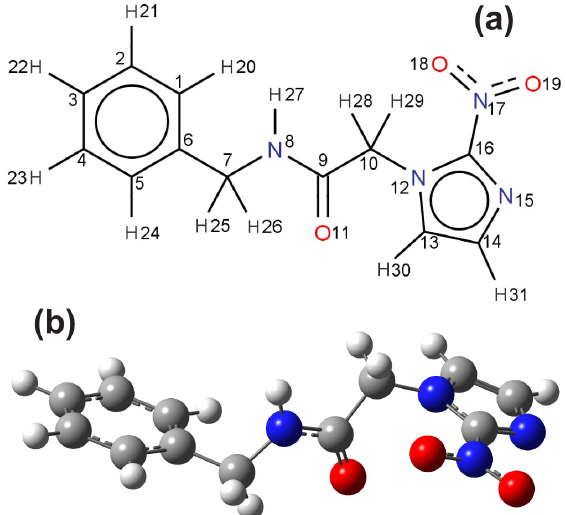
Figure 3. ( a ) Planar representation of benznidazole and atom labels; ( b ) Geometry of the DFT calculated lowest energy conformer of benznidazole using a PCM aqueous solvation model.